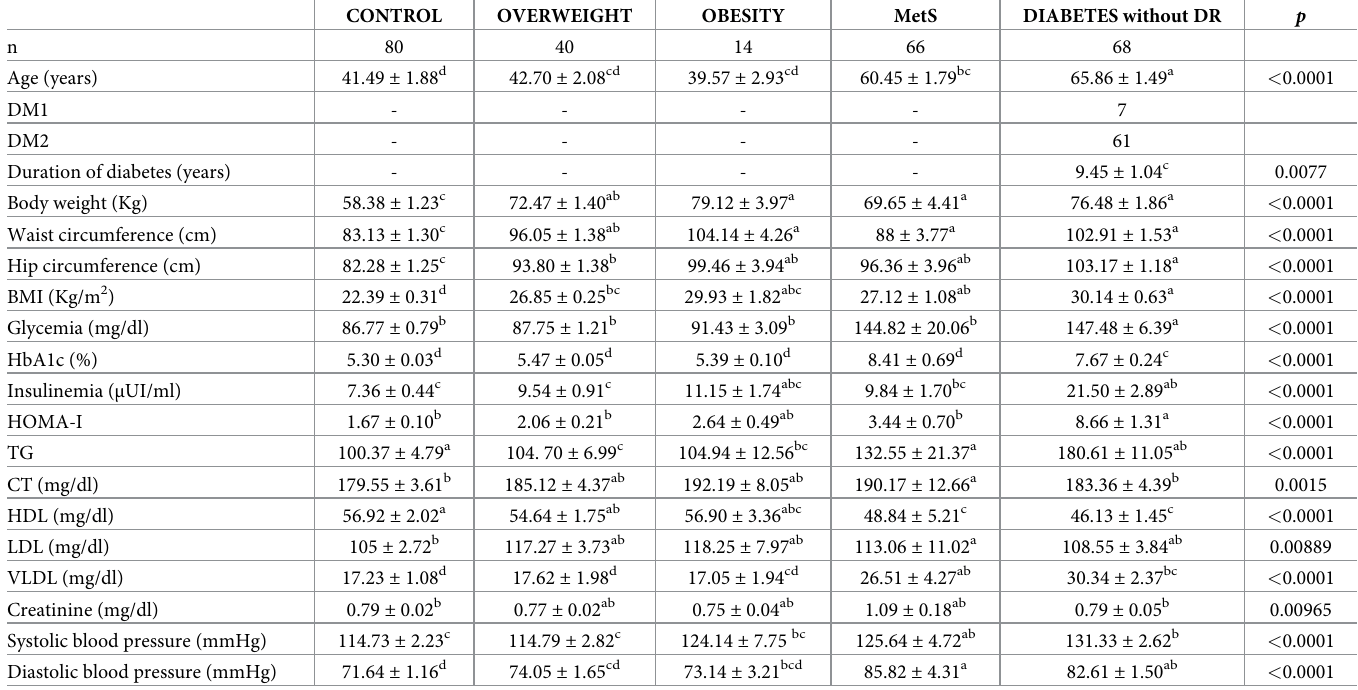
Table 1. Characteristics of the patients studied for model training and test using ERG spectral components from three different recording